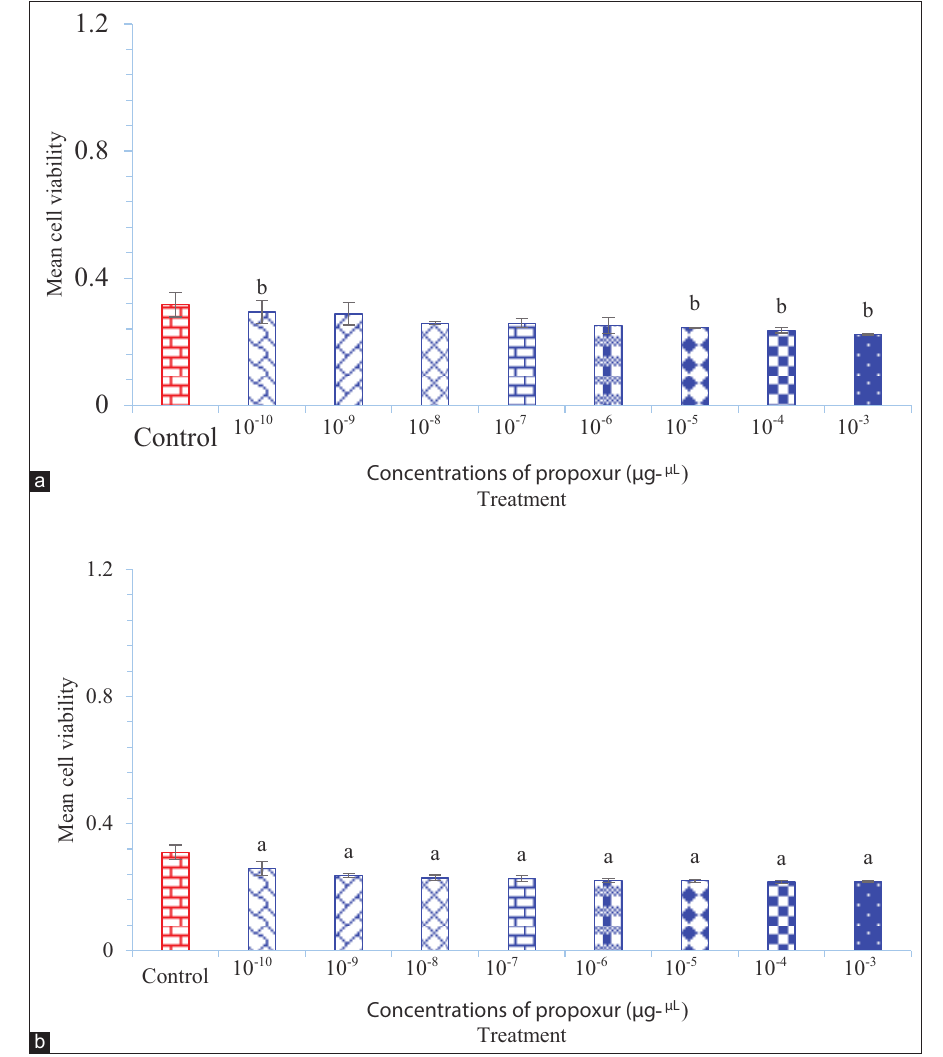
Figure-2: Cytotoxicity of propoxur against invertebrate (Sf9) and vertebrate (L929) cell lines. (a) Propoxur against cell line of Sf9 and (b) propoxur against cell line of L929. Compared with control: (a) p<0.05 and (b) p<0.001. Cell line of Sf9 derived from the ovary gland of the fall armyworm, Spodoptera frugiperda (Smith) (Lepidoptera: Noctuidae). Cell line of L929 derived from mouse fibroblast